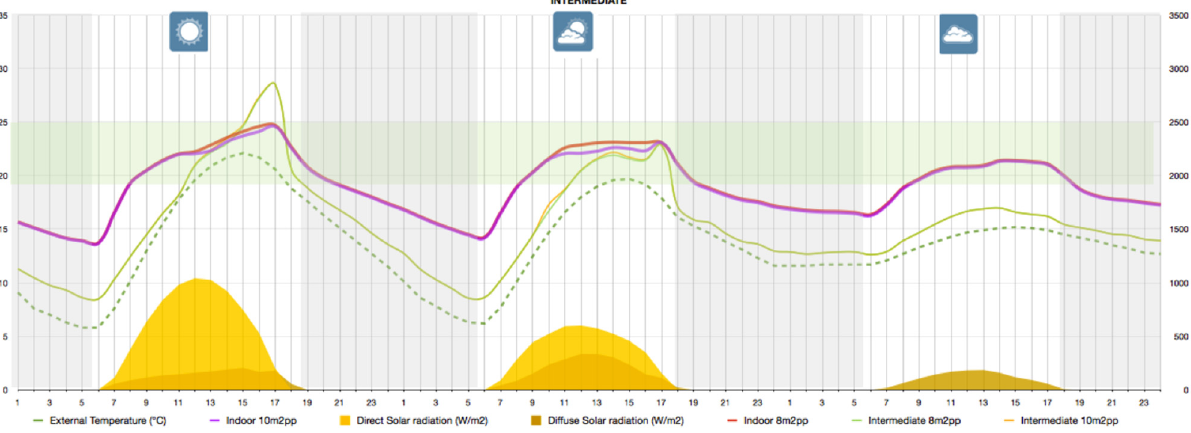
Figure 25. Simulation of the thermal performance of the internal office area when coupled with the intermediate space. The intermediate space contributes to the cooling down of the internal spaces in the peak daily hours of